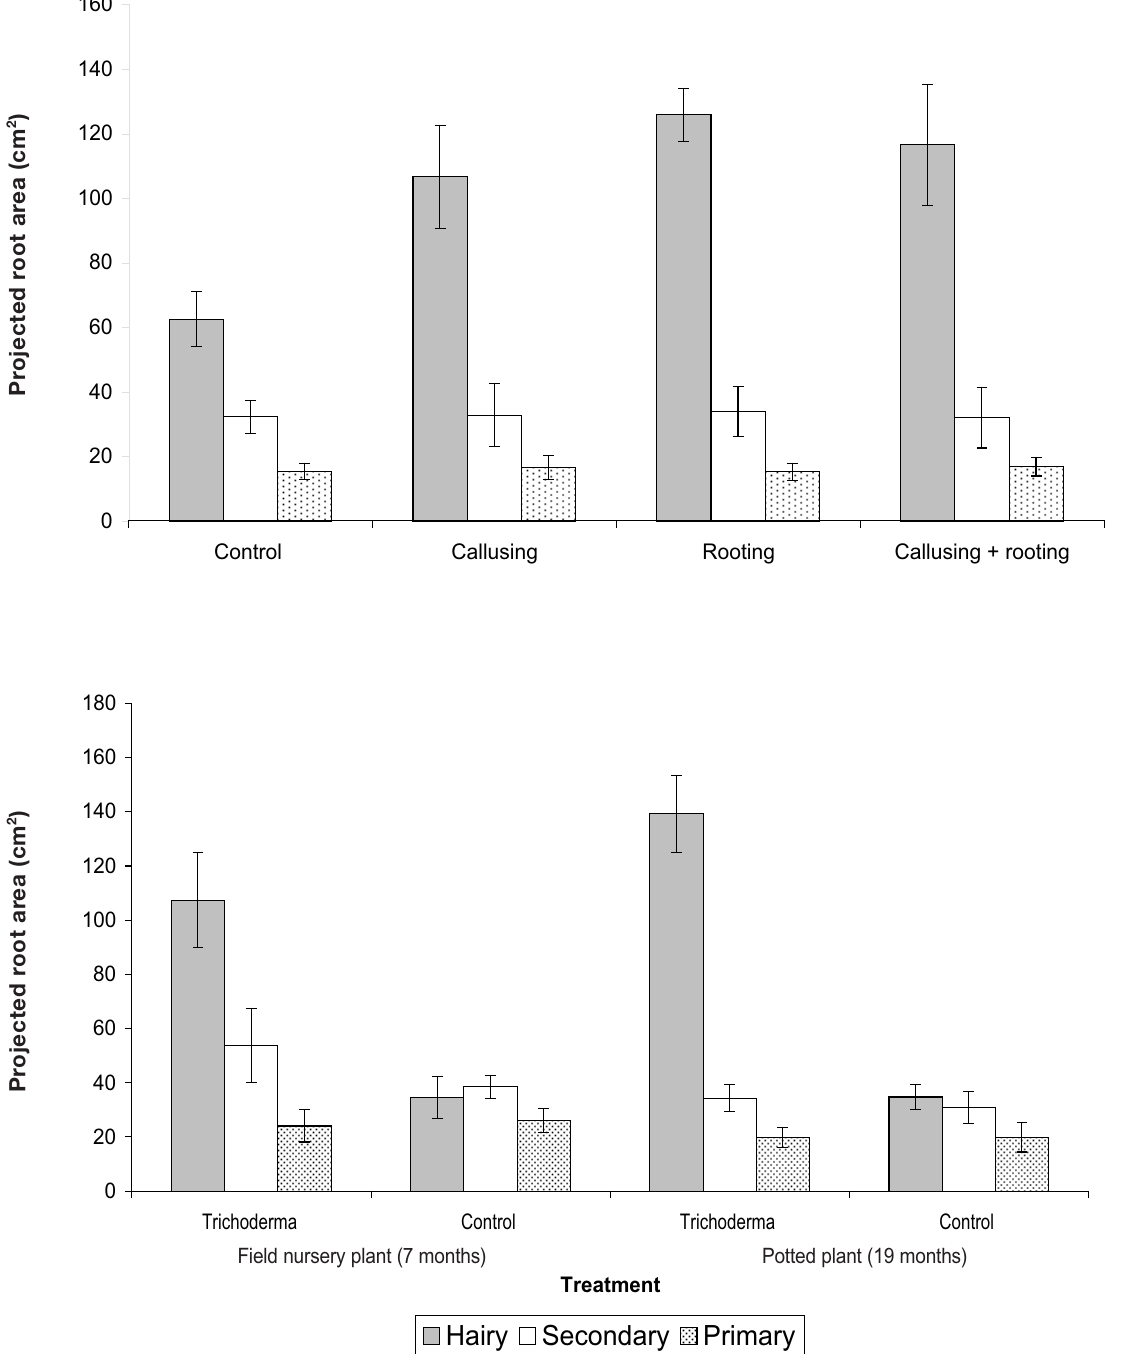
Fig. 5. Effect of Trichoderma applied at various nursery-vine growth stages on the development of the root type of potted Trebbiano romagnolo cuttings on K5BB 7 months after planting (top). The effect of the rooting treatment was assessed on Trebbiano romagnolo on K5BB plants collected from the nursery field at the end of the growing season and on Trebbiano romagnolo on K5BB potted vines 19 months after planting (bottom). Bars represent standard